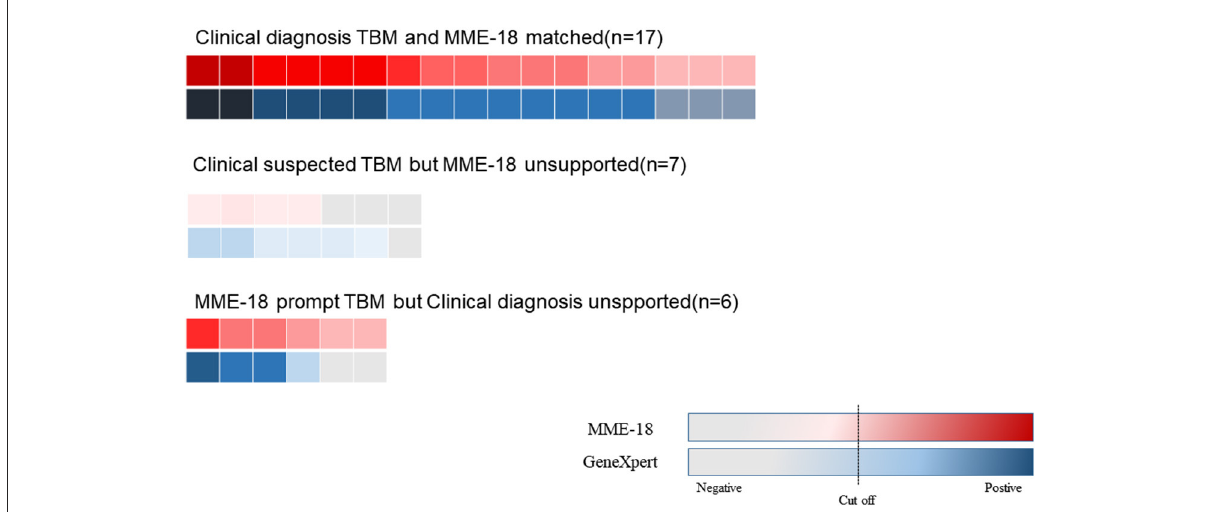
FIGURE3 The comparison of MME-18 and Xpert MTB/RIF of suspected TBM. The consistent rate of MME-18 and Xpert MTB/RIF for the clinically diagnosed TBM was up to 100% (17/17). As for the five cases with solely positive MME-18 results, two cases were negative by Xpert MTB/RI. However, two patients were weakly positive for Xpert MTB/RIF among the seven clinically suspected TBM with negative MME-18